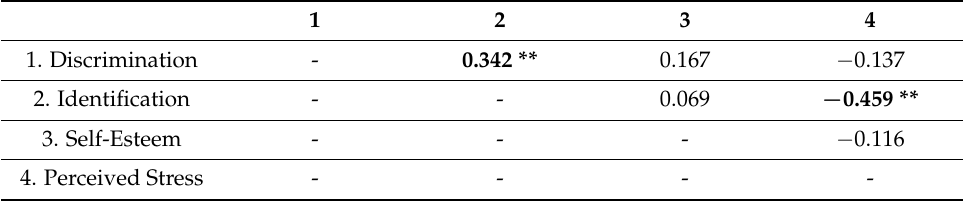
Table 1. Correlations between discrimination, identification, self-esteem and perceived stress.